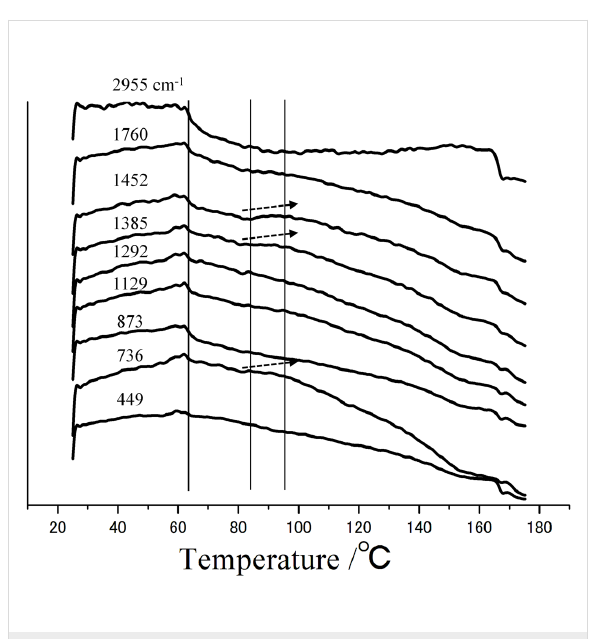
Figure 10: PCA results of PL-MCD83 at 2955 cm − 1 , 1768 cm − 1 , 1452 cm − 1 , 1385 cm − 1 , 1294 cm − 1 , 1128 cm − 1 , 873 cm − 1 , 736 cm − 1 and 449 cm − 1